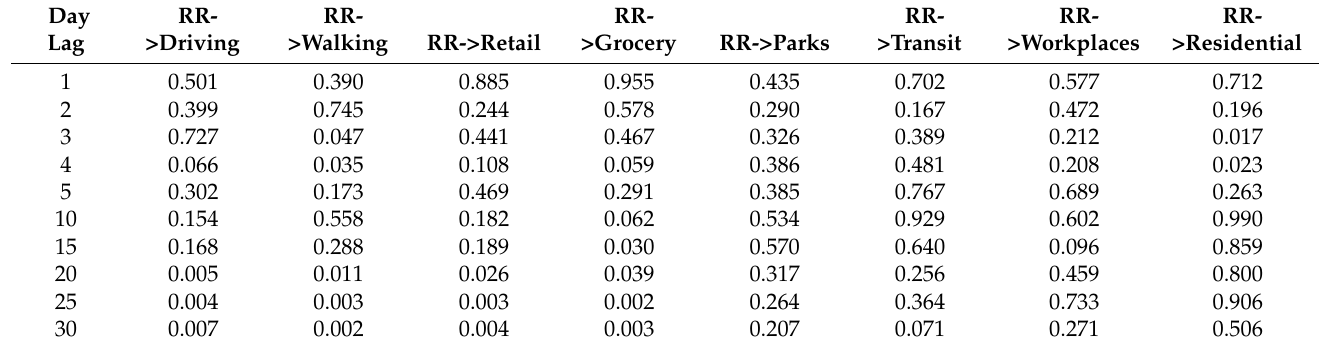
Table A19. Reproduction rate (RR), Granger-cause mobility variables, and p -values in day lags in